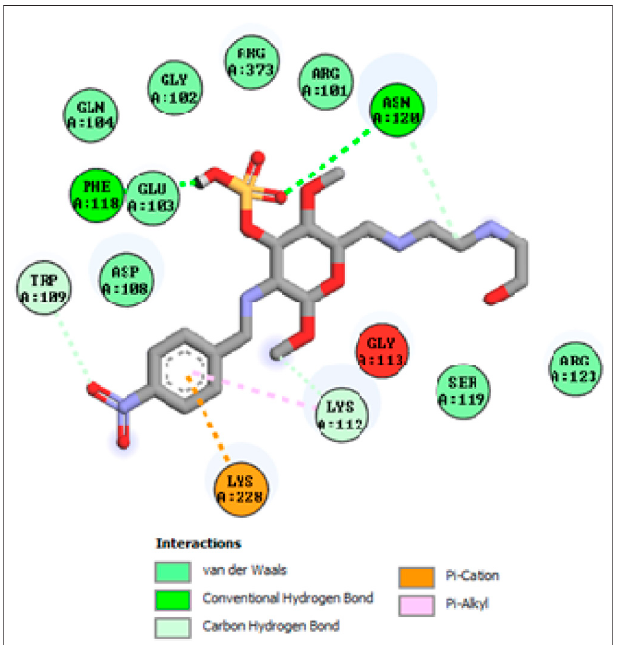
FIGURE 11 | Interaction of compound 2g in the binding pocket of 1Z11 receptor.